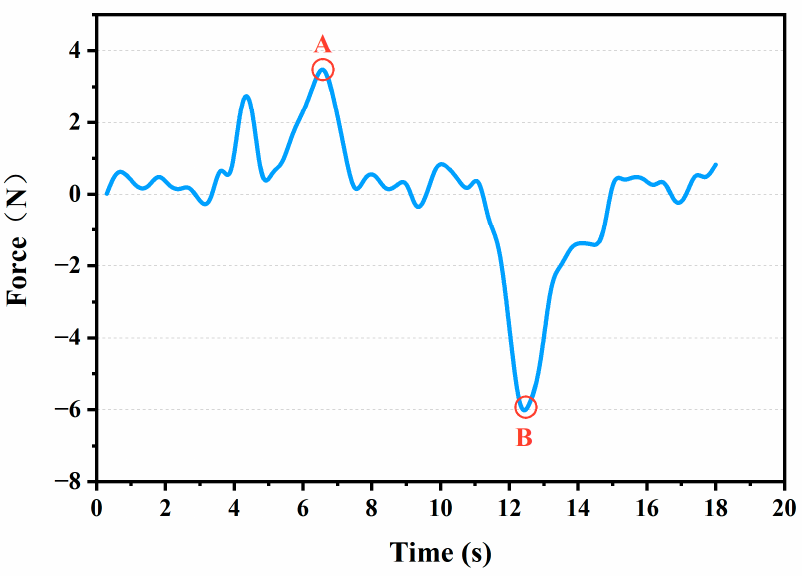
Figure 11. The contact force in the X direction by the integrated position/force controller.